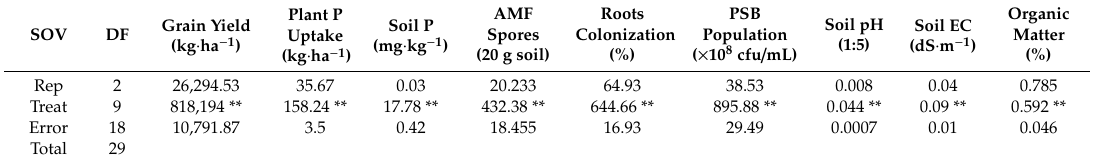
Table 6. Mean square values for the soil and plant parameters as influenced by the applied AMF and PSB with RP in wheat